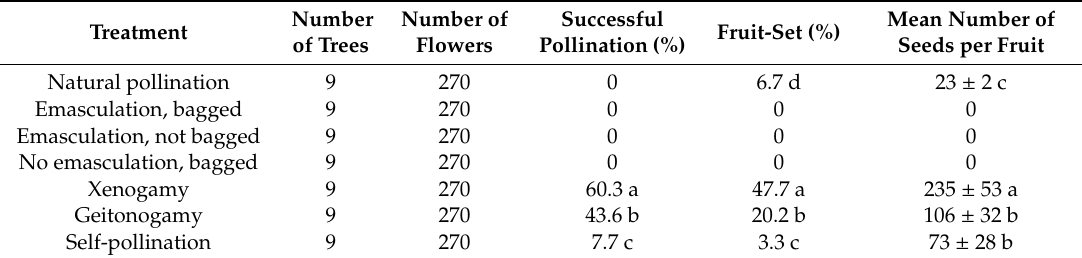
Table 6. Seed-set in M. conifera following di ff erent pollination